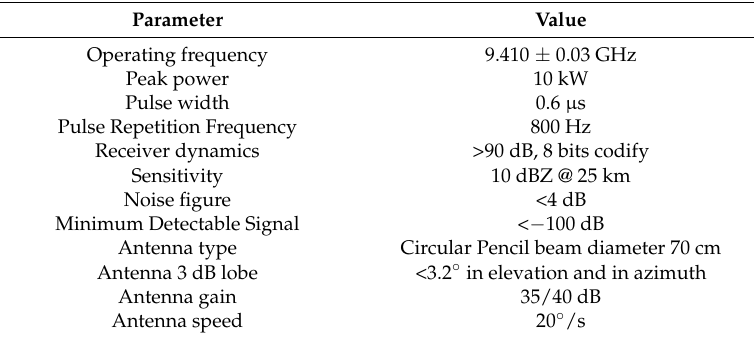
Table 1. WR10X radar technical